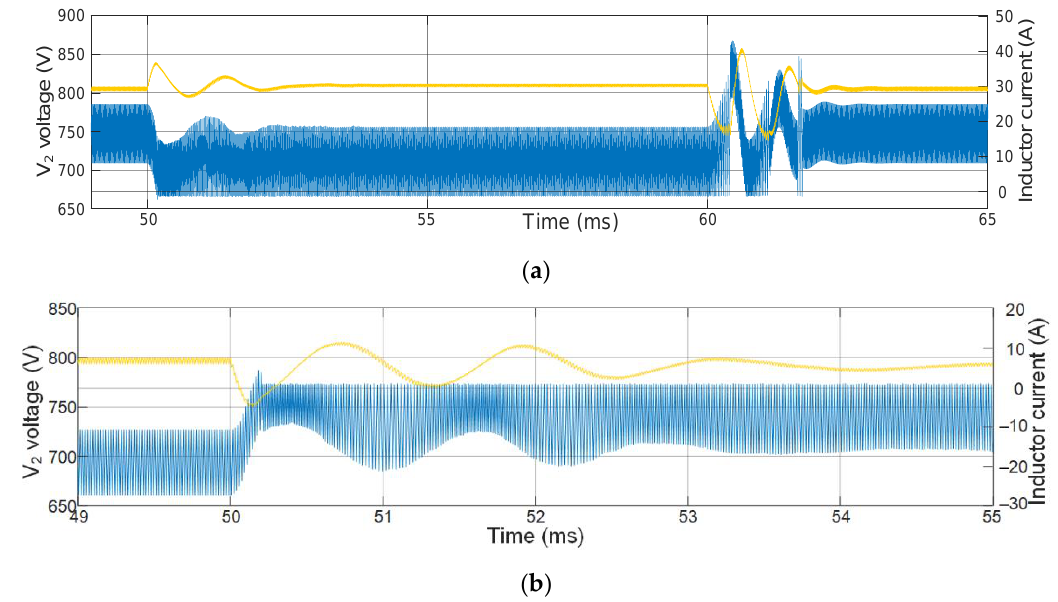
Figure 9. Simulation results changing among conduction modes. ( a ) Power flows from V 1 to V 2 and changes from 6.2 kW to 3.5 kW at t = 50 ms and from 3.5 kW to 6.2 kW at t = 60 ms are promoted. ( b ) Power flows from V 2 to V 1 and change from 8 kW to 3.2 kW at t = 50 ms is promoted. V 2 in yellow and I L in blue.